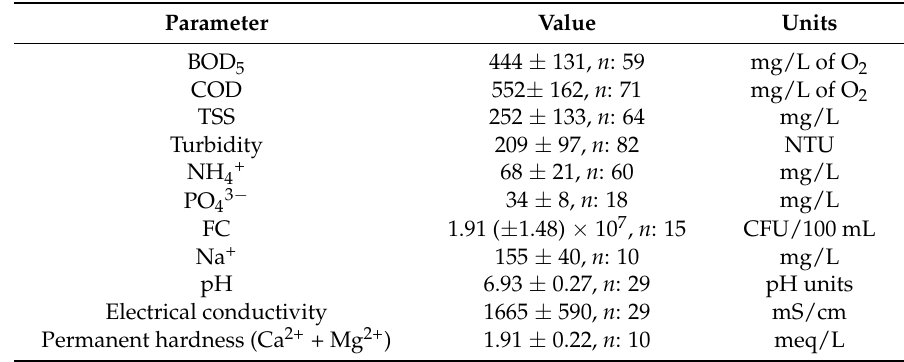
Table 1. Characteristics of the wastewater used in this work. Average concentrations ± standard deviation and number of data ( n ) between January 2013 and July 2014.